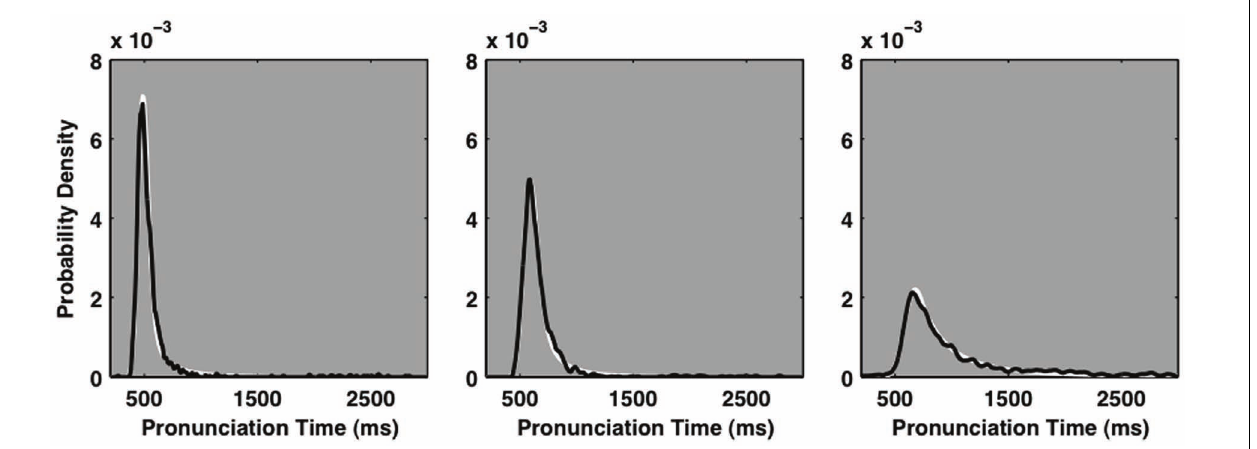
empirical probability density functions. Maximum-likelihood fits of the refined cocktail description are depicted in white, behind the empirical density functions. In each plot, the white line depicting the cocktail fit is hardly visible because it closely matches the empirical